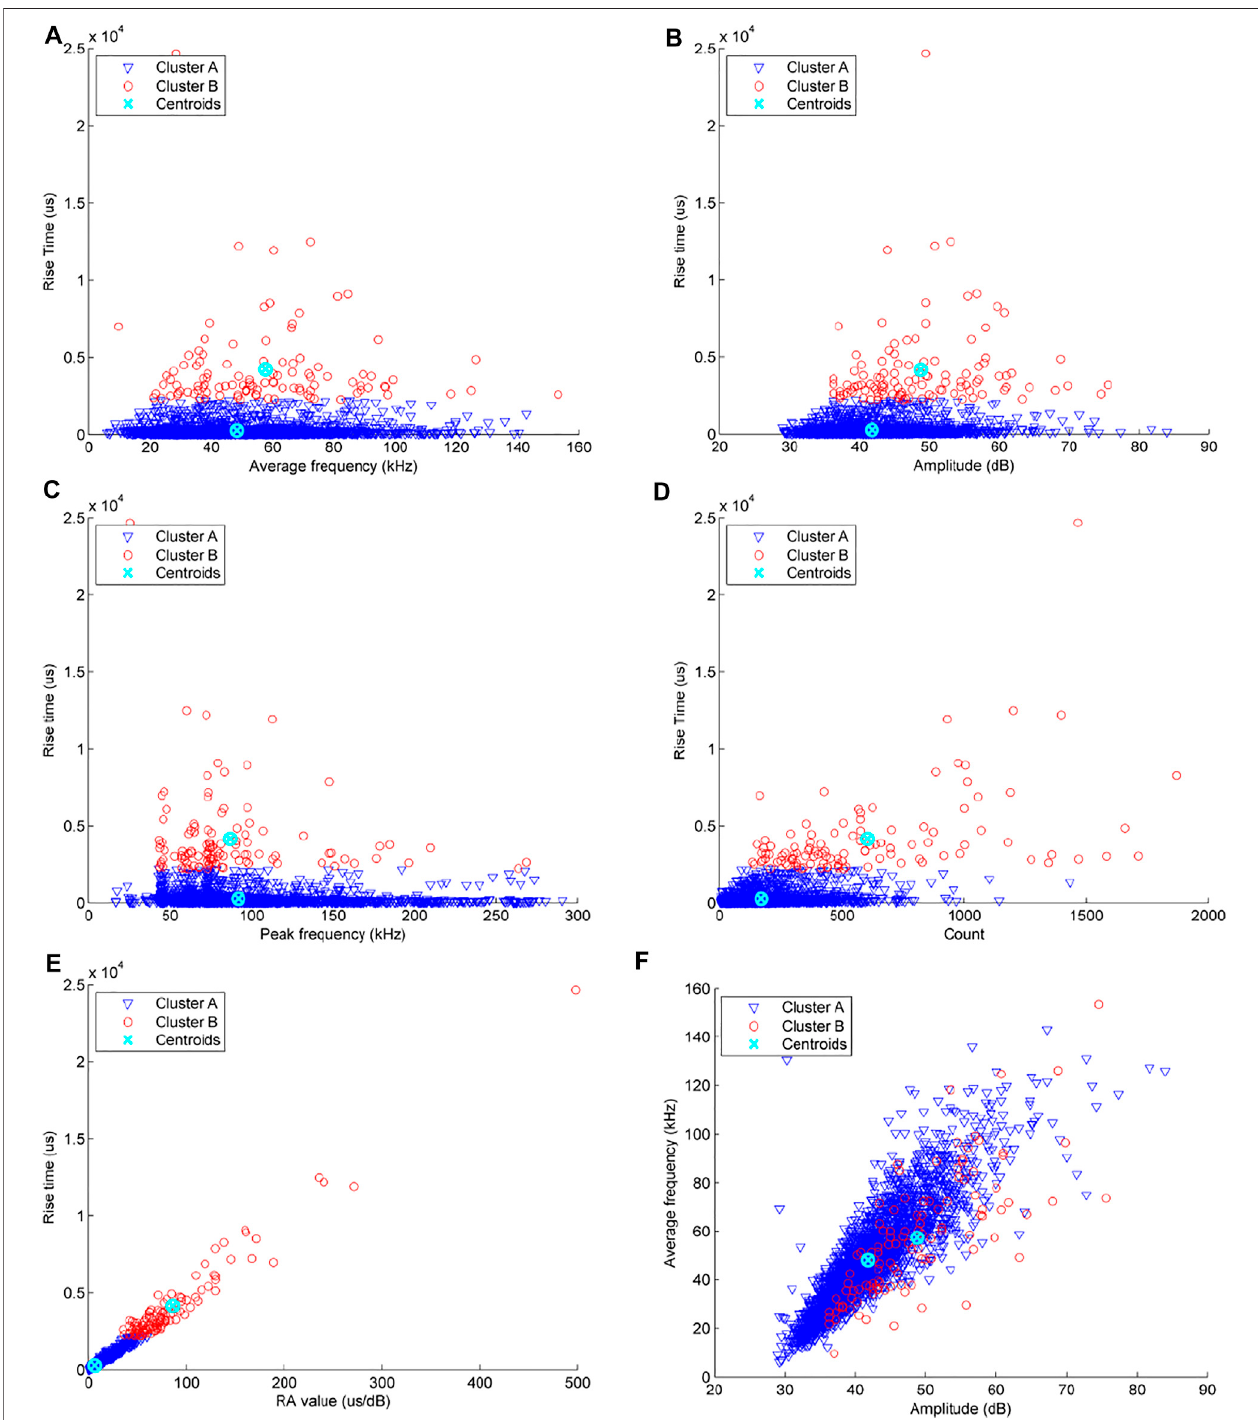
FIGURE6| ThedistributionoftwoclustersofAEsignal(labelledclusterAandBrespectively)ofrockunderuniaxialcompressionin (A) Averagefrequency-Risetime space, (B) Amplitude-Rise time space, (C) Peak frequency-Rise time space, (D) Count-Rise time space, (E) RA value-Rise time space, (F) Amplitude-Average frequency space.